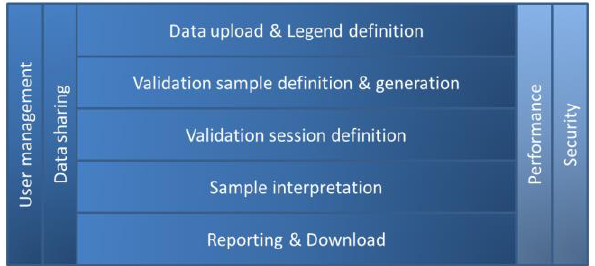
Figure 1. LACO-Wiki feature overview